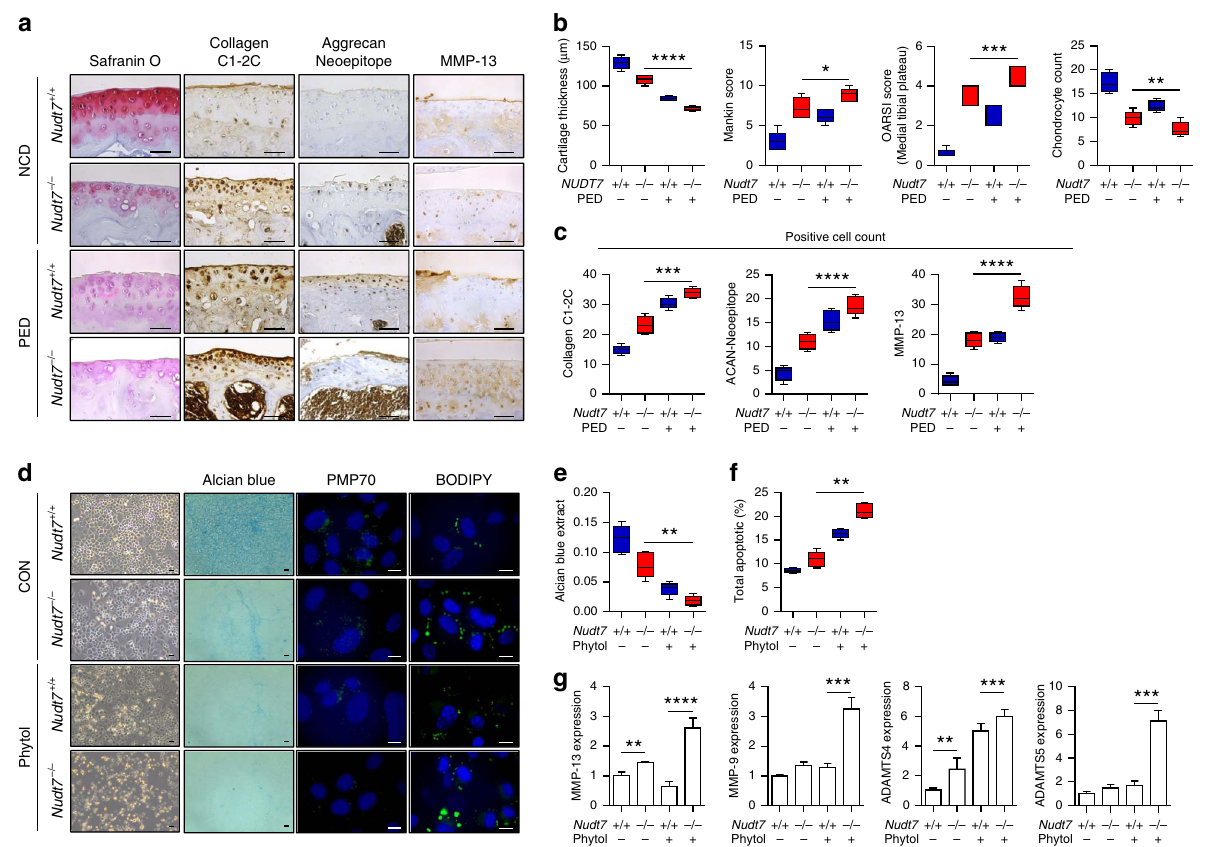
Fig. 2 Nudt7 − / − mice have severe cartilage degradation and chondrocyte degeneration. a Staining of Collagen C1-2C, Aggrecan Neoepitope, and matrix metalloproteinase (MMP)-13 of paraf fi n sections from the articular cartilage of Nudt7 + / + and Nudt7 − / − mice ( n = 5 per group). Scale bars, 50 μ m. b Analysis of cartilage thickness, Mankin score, and chondrocyte number using destabilization of the medial meniscus (DMM)-induced Nudt7 + / + or Nudt7 − / − mice under a normal- (NCD) or phytol-enriched diet (PED) from Fig. 2a ( n = 5 per group). c Positive cell number of Collagen C1-2C, Aggrecan (ACAN) Neoepitope, and MMP-13 in DMM-induced Nudt7 + / + or Nudt7 − / − mice under a NCD or PED from Fig. 2a ( n = 5 per group). d Staining of Alcian blue, PMP70, BODIPY 493/508 using iMACs of Nudt7 + / + and Nudt7 − / − mice at postnatal day 6 under a control (CON) or 50 mM phytol treatment (phytol; n = 5 per group). Scale bars, 10 μ m. e Quanti fi cation of Alcian blue staining extracted with 6M Guanidine-HCl was measured in 650 nm absorbance ( n = 5 per group). f Analysis of apoptotic cell death in iMACs of Nudt7 − / − mice at postnatal day 6 under CON or phytol conditions compared with those of Nudt7 + / + mice ( n = 6 per group). g Transcription level of MMP-13 and -9, ADAMTS-4 and -5 in CON and phytol in iMACs of Nudt7 − / − mice at postnatal day 6 under CON or phytol conditions compared with those of Nudt7 + / + mice ( n = 3 per group). Values are means + s.d. A one-way ANOVA was used for statistical analysis ( b , c , e and f ). Values are means + s.d. An unpaired Student ’ s t test was used for statistical analysis ( g ). * P < 0.05, ** P < 0.01, *** P < 0.001, **** P < (Fig. 4e); and suppression of chondrocyte proliferation (Fig. 4f). apoptosis . In fl ammatory imbalance is one of the major char- Furthermore, we re-con fi rmed the increased expression levels of acteristics of OA 28 . In fl ammatory cytokines including tumor in fl ammatory cytokines in a dose-dependent manner by the introduction of PGAM1 (Fig. 4g). H3K4me3 is responsible for the activation of PGAM1 . H3K4me3 on a promoter is known to activate the gene expres- sion. Here, we observed an increased level of H3K4me3 both in human OA cartilage compared with that in non-OA cartilage (Fig. 5a) and in the cartilage of Nudt7 − / − mice compared with that in the cartilage of Nudt7 + / + mice (Fig. 5b). Furthermore, the number of H3K4me3-positive cells increased in Nudt7 − / − iMACs by approximately twofold (Fig. 5c); however, the number of H3K27me3-positive cells decreased (Supplementary Fig. 8). Next, we con fi rmed the direct interaction of H3K4me3 with the PGAM1 promoter by a chromatin immunoprecipitation (ChIP) assay. As a result, we showed increased H3K4me3 levels in Nudt7 − / − iMACs compared with those in Nudt7 + / + (Fig. 5d). The in vivo delivery of a PGAM1 -speci fi c shRNA ( shPGAM1 ) into the cartilage of Nudt7 − / − mice suppressed cartilage